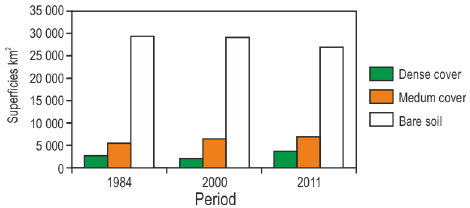
Fig. 2. Distribution of land cover superficies